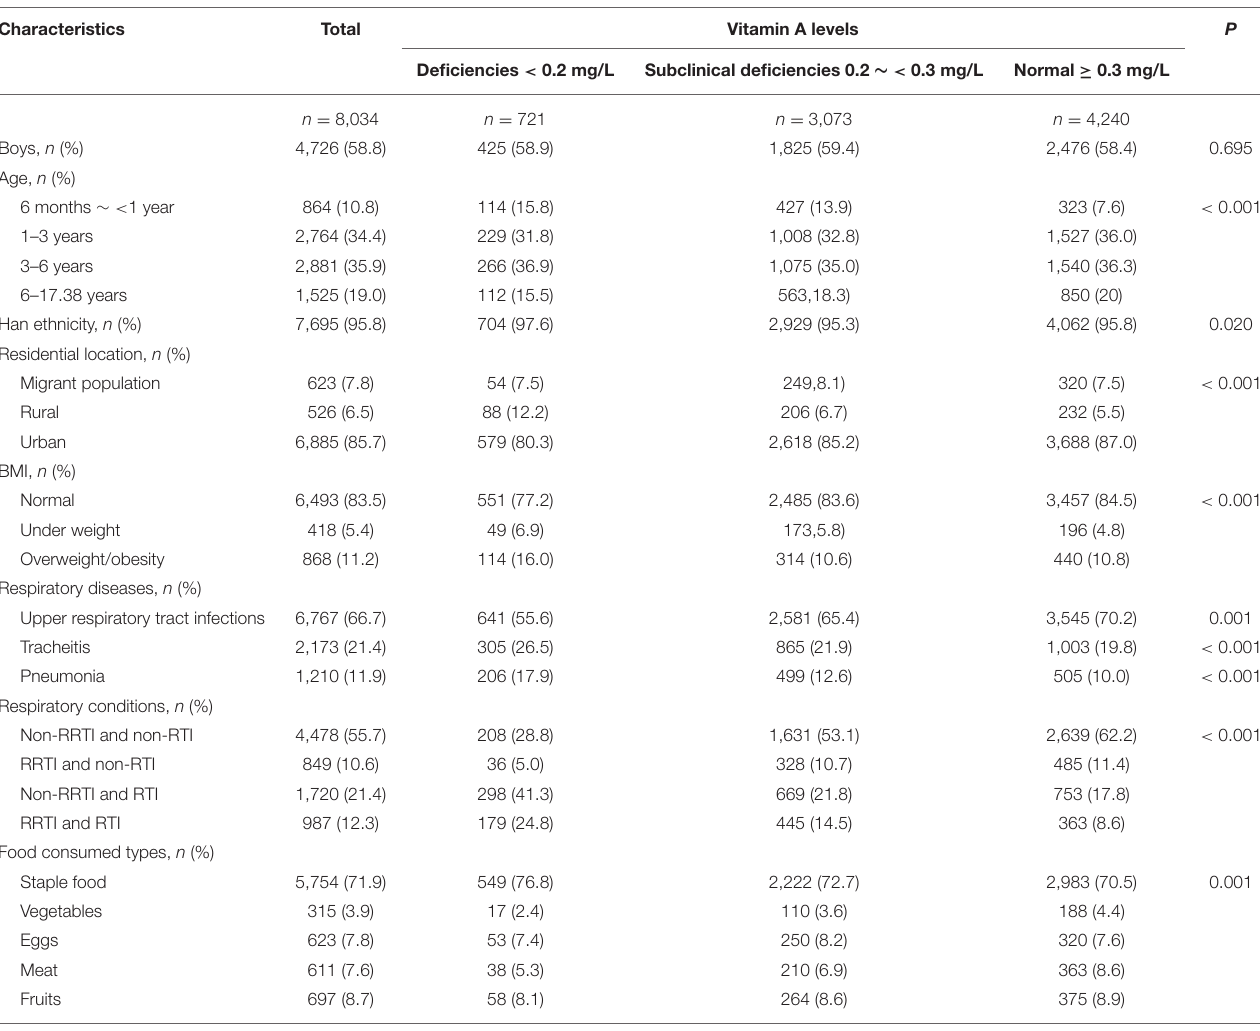
TABLE 1 | Characteristics of 8,034 children and adolescents according to the serum vitamin A levels. Characteristics